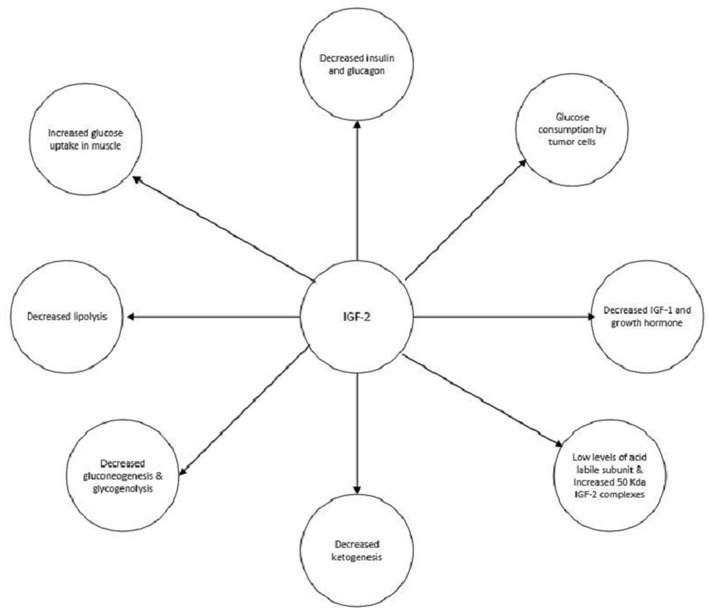
Mechanisms by which IGF-2 induced hypoglycemia.